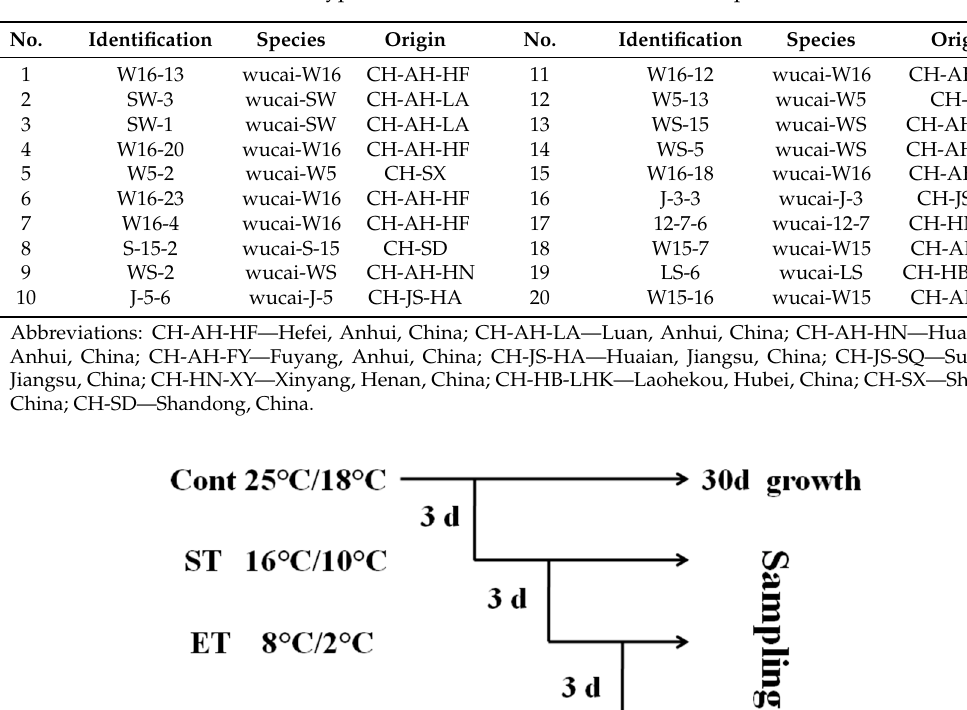
Table 1. Genotypes measured in the climate chamber experiments.